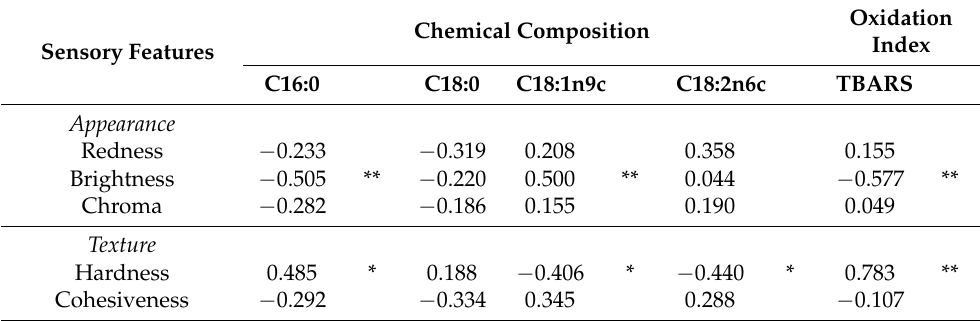
Table 5. Pearson’s correlation coefficients ( R 2 ) between chemical parameters/oxidation index and sensory features of